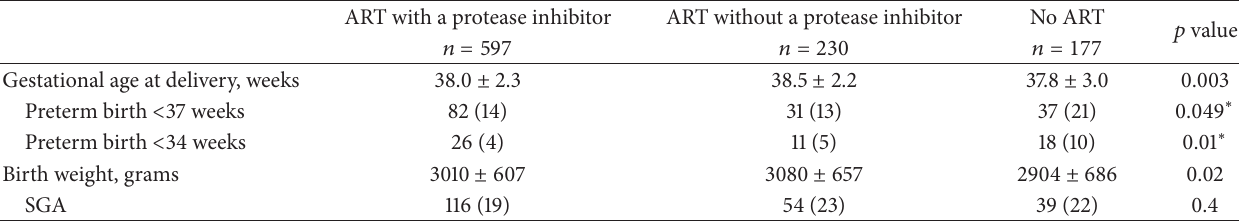
Table 3: Selected pregnancy outcomes in HIV-infected women according to protease inhibitor use.